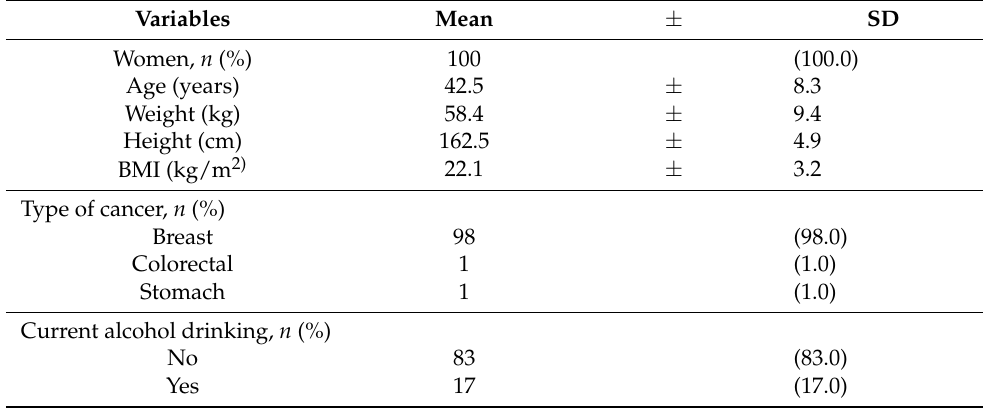
Table 3. General characteristics of participants ( n =